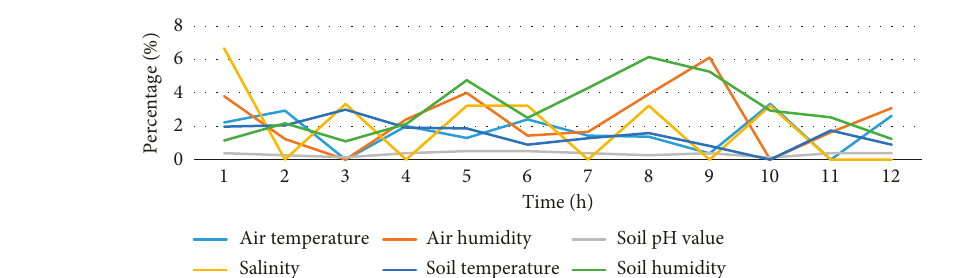
Figure 11: Comparison of parameters.